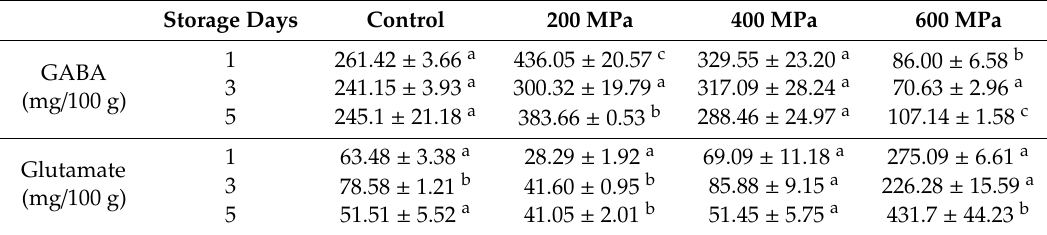
Table 1. Influence of high-pressure processing (HPP) treatment and storage on gamma aminobutyric acid (GABA) and L-glutamate. acid (GABA) and L-glutamate.